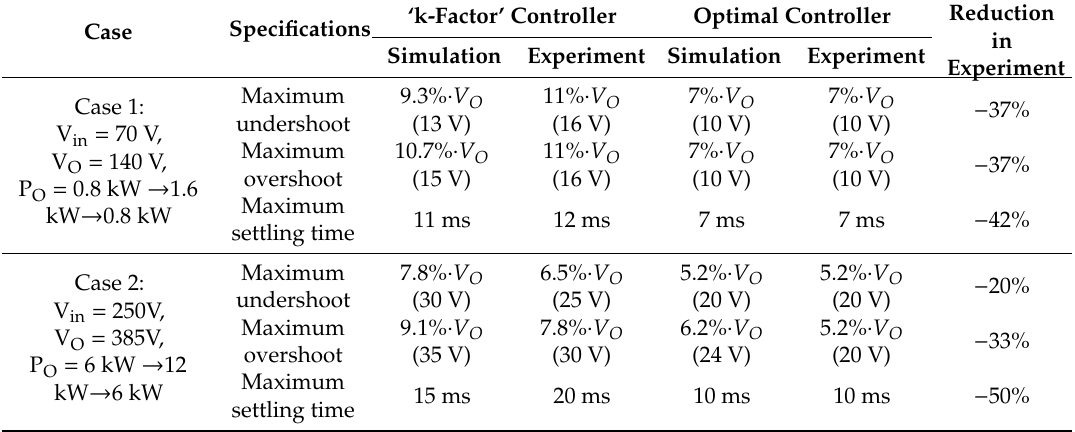
Table 8. Comparative closed-loop performance for output voltage response of ‘k-factor’ based controller and optimal